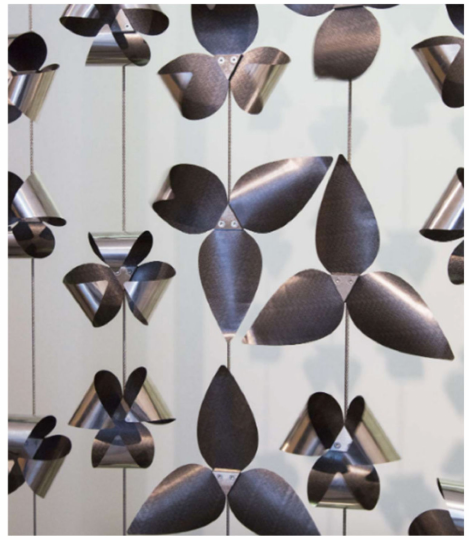
Figure 7. CIRC adaptative solar protections (© Art&Build).